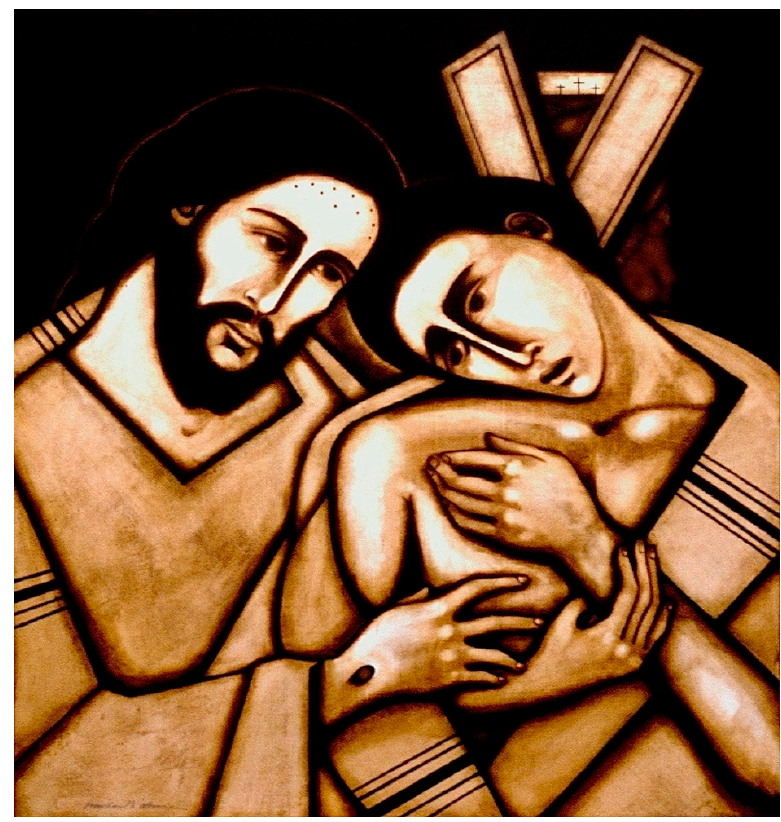
Figure 4. Christ and